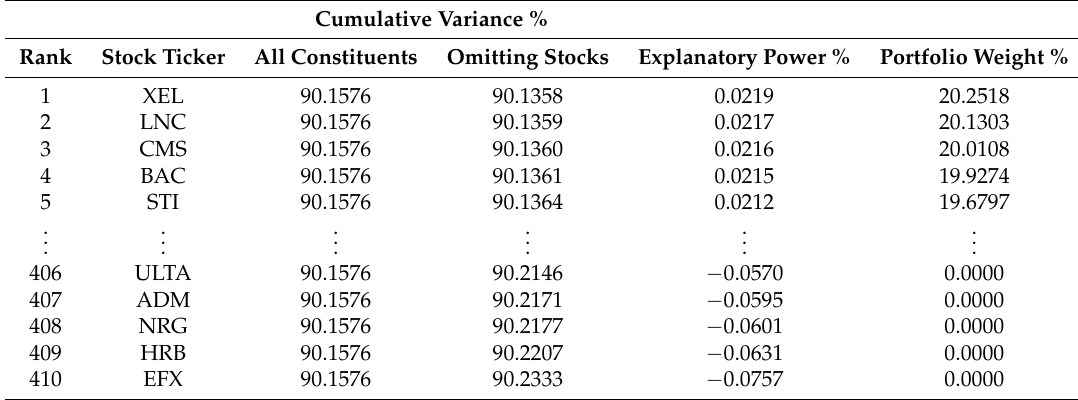
Table 2. Ranking of the index constituents by explanatory power and portfolio